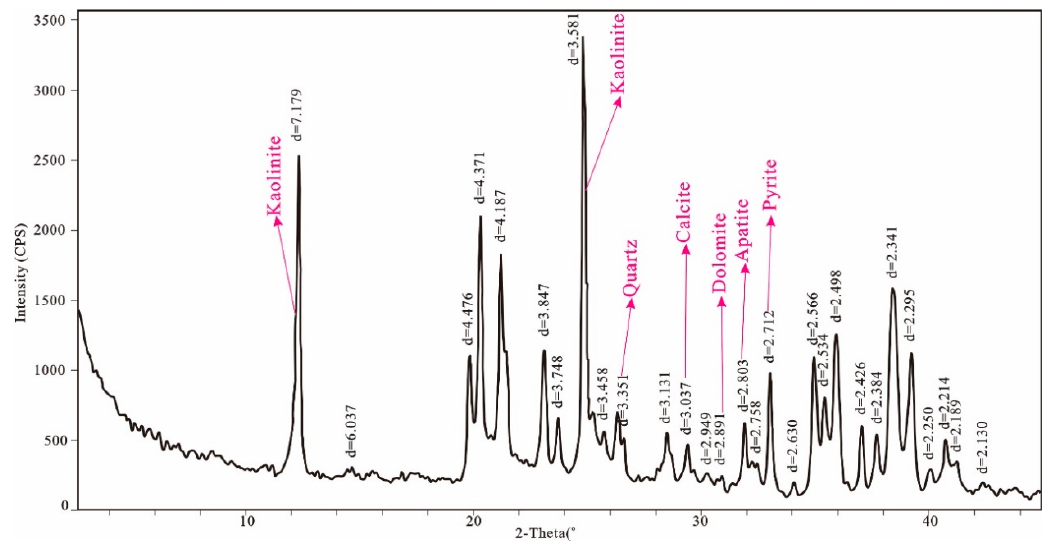
Figure 9. Power X-ray diffraction pattern of the low temperature ash of sample DP5 -2 -8 from Dongpo Mine.